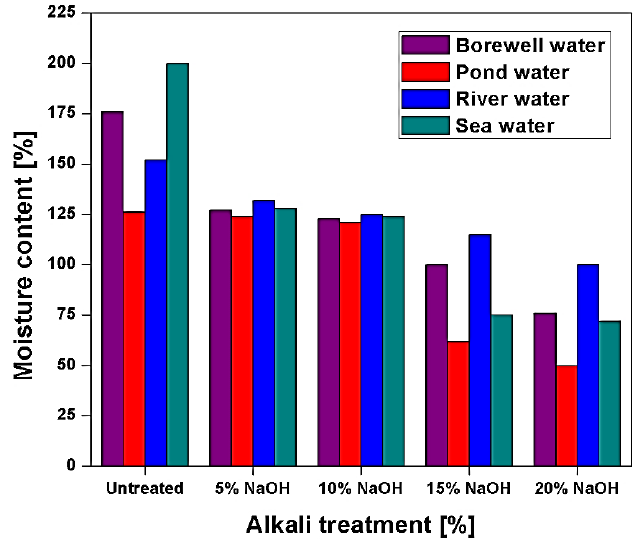
Figure 13. Water absorption tendency of untreated and alkali (NaOH)-treated single abaca fibre from different water sources [85]. different water sources [85].